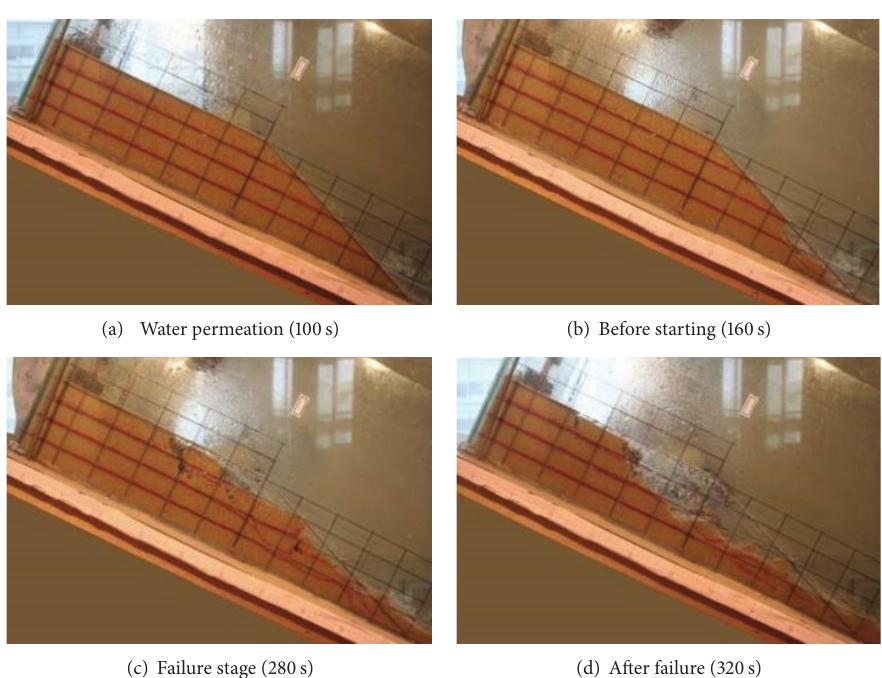
Figure 4: The failure process of debris flow (side